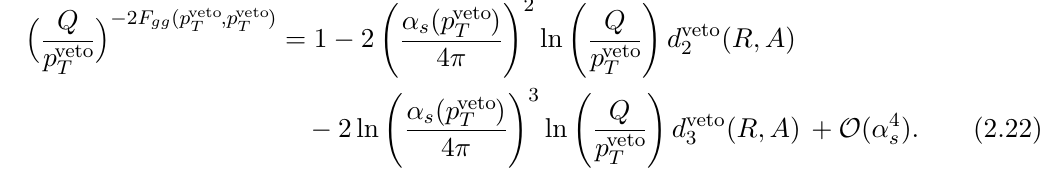
as given by eq. (2.24) with Q = 125 GeV and n 3 = 0 : R = 1 (black), R = 0 . 5 (red, dashed), R 0 0 3